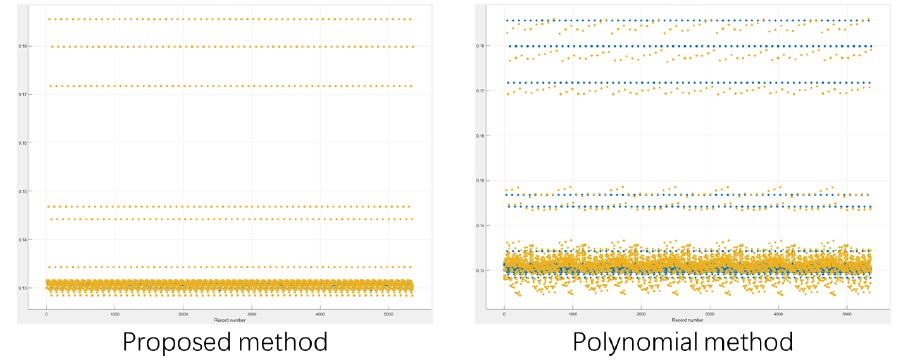
Figure 4. Comparison of proposed and polynomial method results of Σ